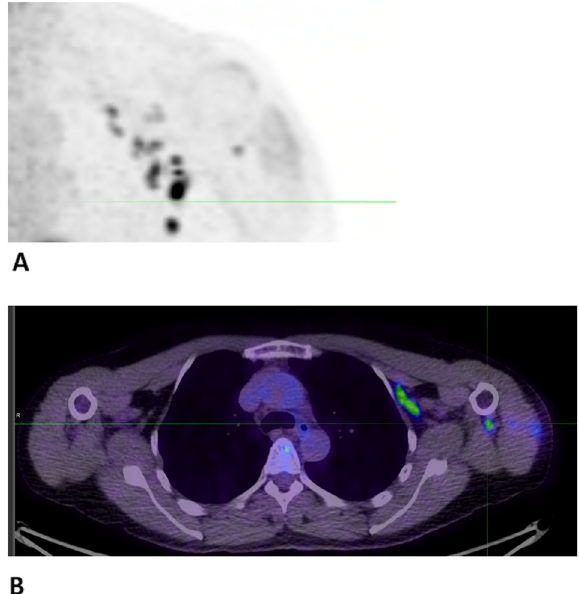
Fig. 1 Immune activation imaged by FDG-PET. FDG-PET/CT images of a patient FDG-avid left axillary lymphadenopathy after COVID-19 vaccination, re fl ecting glucose metabolism in immune cells. In the maximum intensity projection image (panel A ), lymph nodes appear as black spots and in the transverse PET/CT image (panel B ) as light green regions.